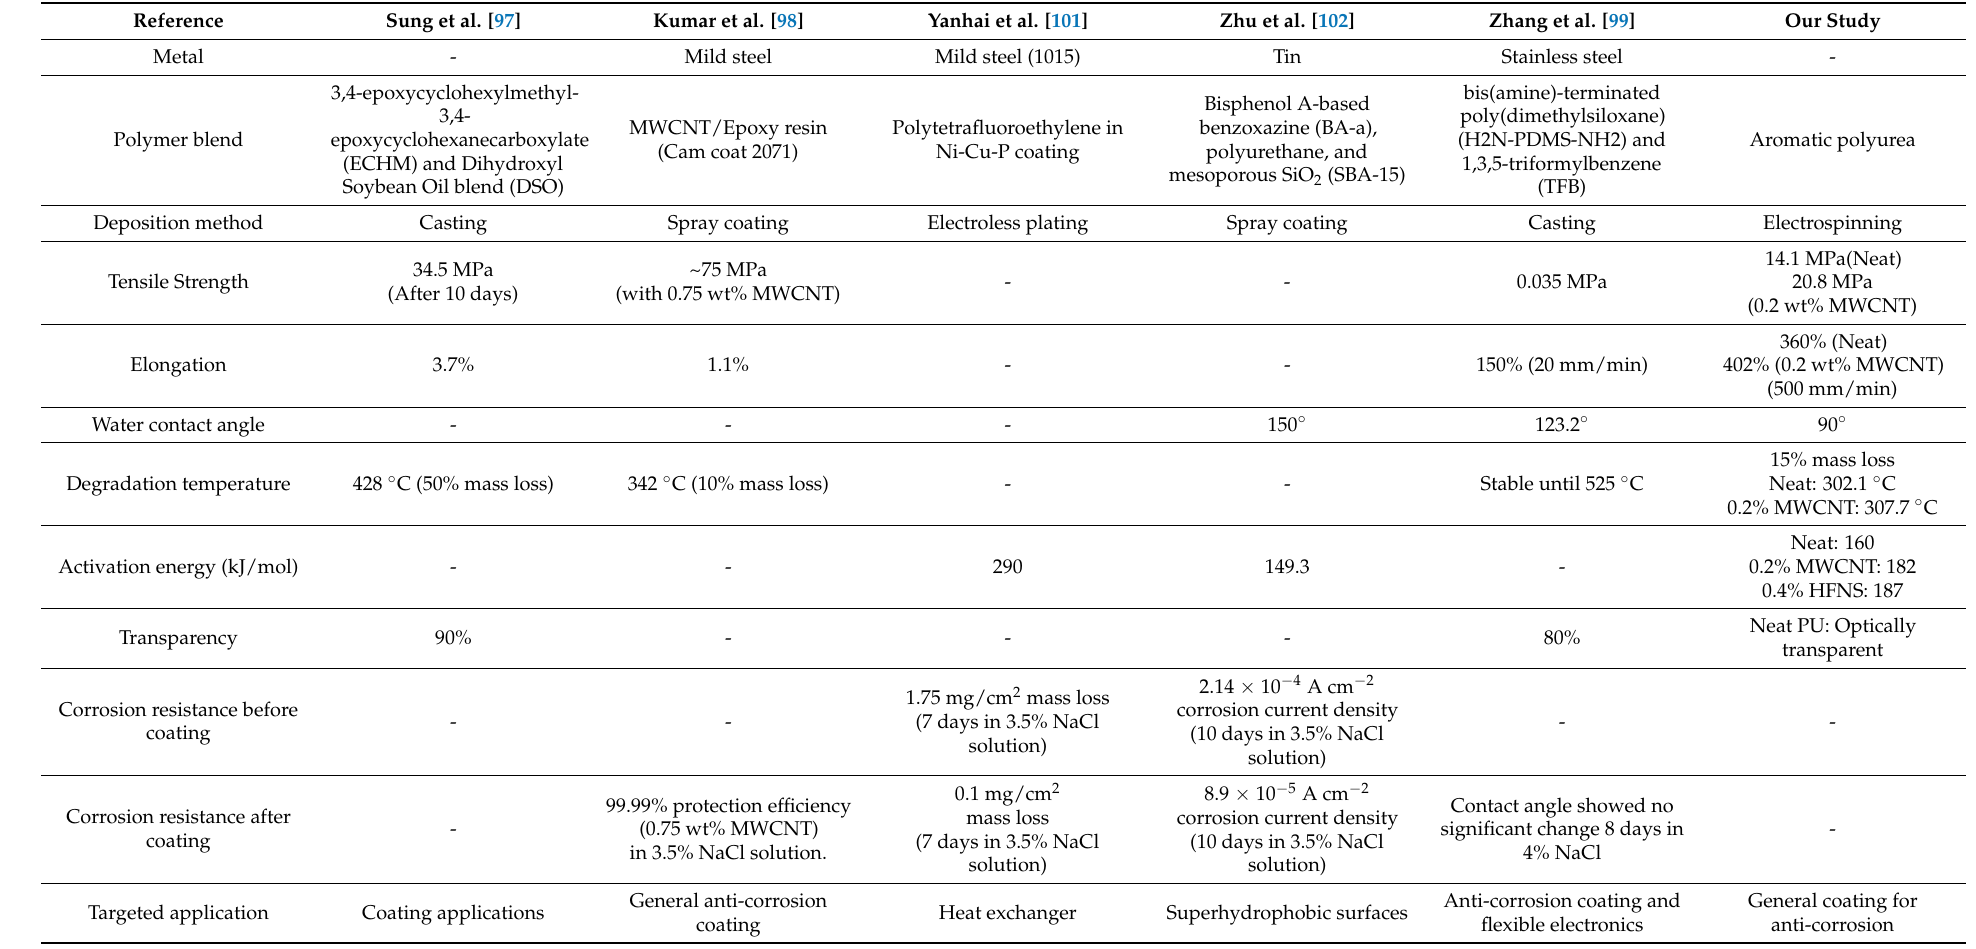
Table 3. Comparison between some previous research on anti-corrosive coatings and this